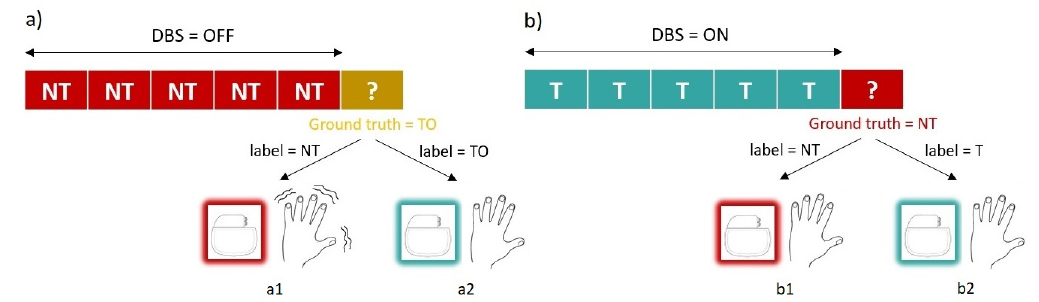
Figure 3. This figure represents the four cases that can take place in our system when turning on/off the stimulation. ( a ) The Implantable Medical Device (IMD) is not stimulating, and a TO sample arrives (the ground-truth of the sample is therefore TO). If the system fails to classify that sample, the stimulation will remain OFF, and the patient will begin to tremble after a few seconds (Scenario a1 in the figure). If on the contrary, the system correctly identifies the sample as TO , it will order to start the stimulation (Scenario a2 in the figure). ( b ) If while the system is stimulating, an NT sample arrives: (the ground-truth of the sample is therefore NT ): If the system correctly detects this new clinical state, it will turn OFF the stimulation, as it is no longer necessary (Scenario b1 in the figure), while if the detection fails, the system will continue to stimulate (Scenario b1 in the figure). However, in this case, contrary to what happens in Scenario a1, this will have no physical effects on the